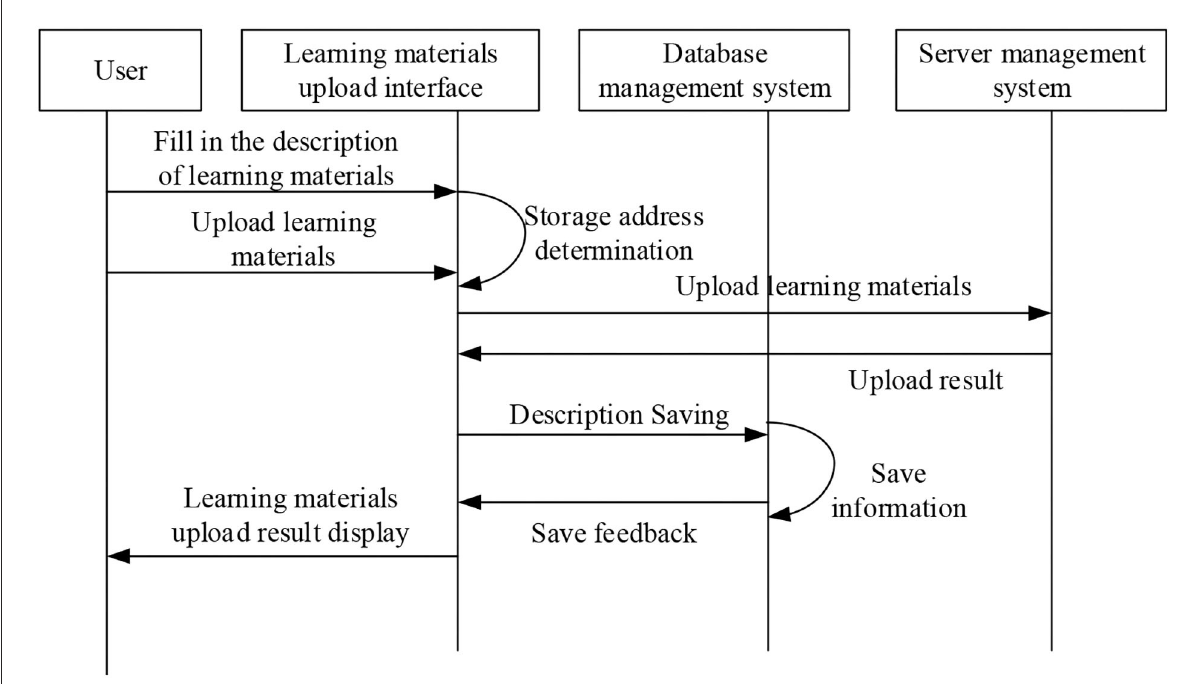
FIGURE15 Sequence diagram of the micro-video